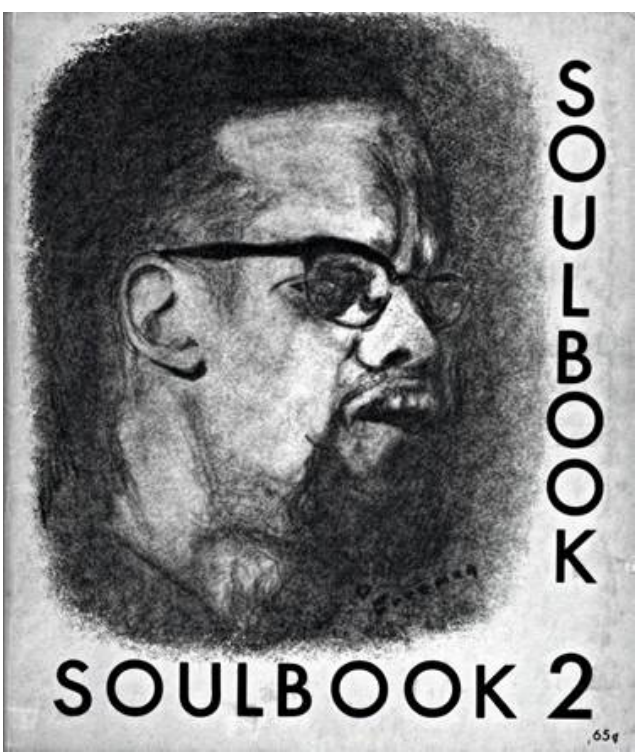
Figure 4 Cover of Soulbook , spring 1965. Donald